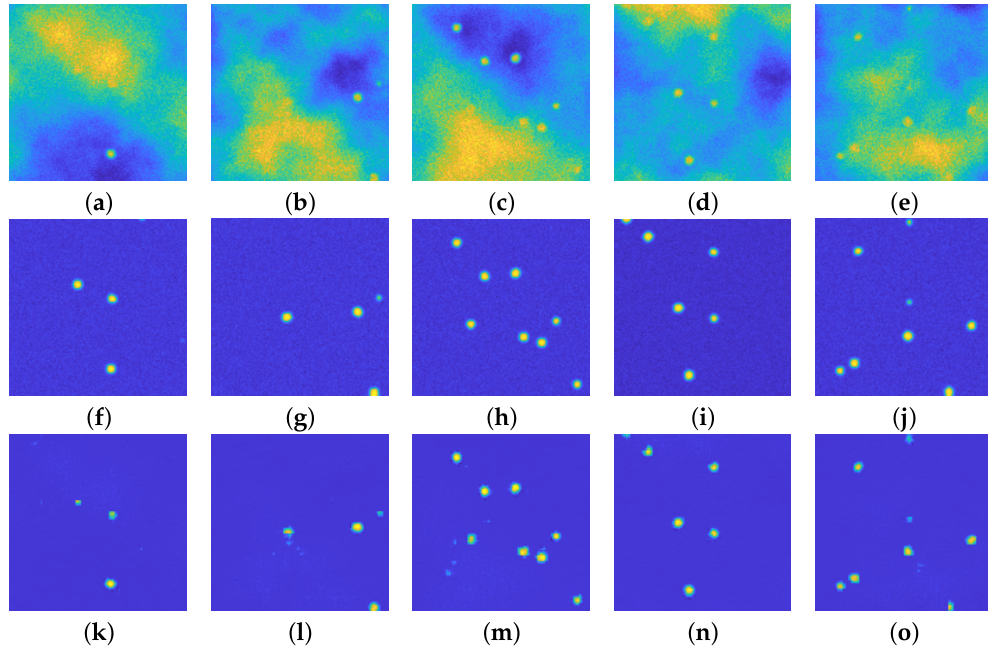
Figure 7. ( a – e ): Perturbed images. ( f – j ): relative ground truths. ( k – o ): recovered images via the proposed approach. In each of the 5 example cases, the particles are well recognized, even the faint ones. Small artifacts arise (see ( l , m ) due to the presence of background emission of high intensity. All the images are displayed with values in [ 0,255 ]